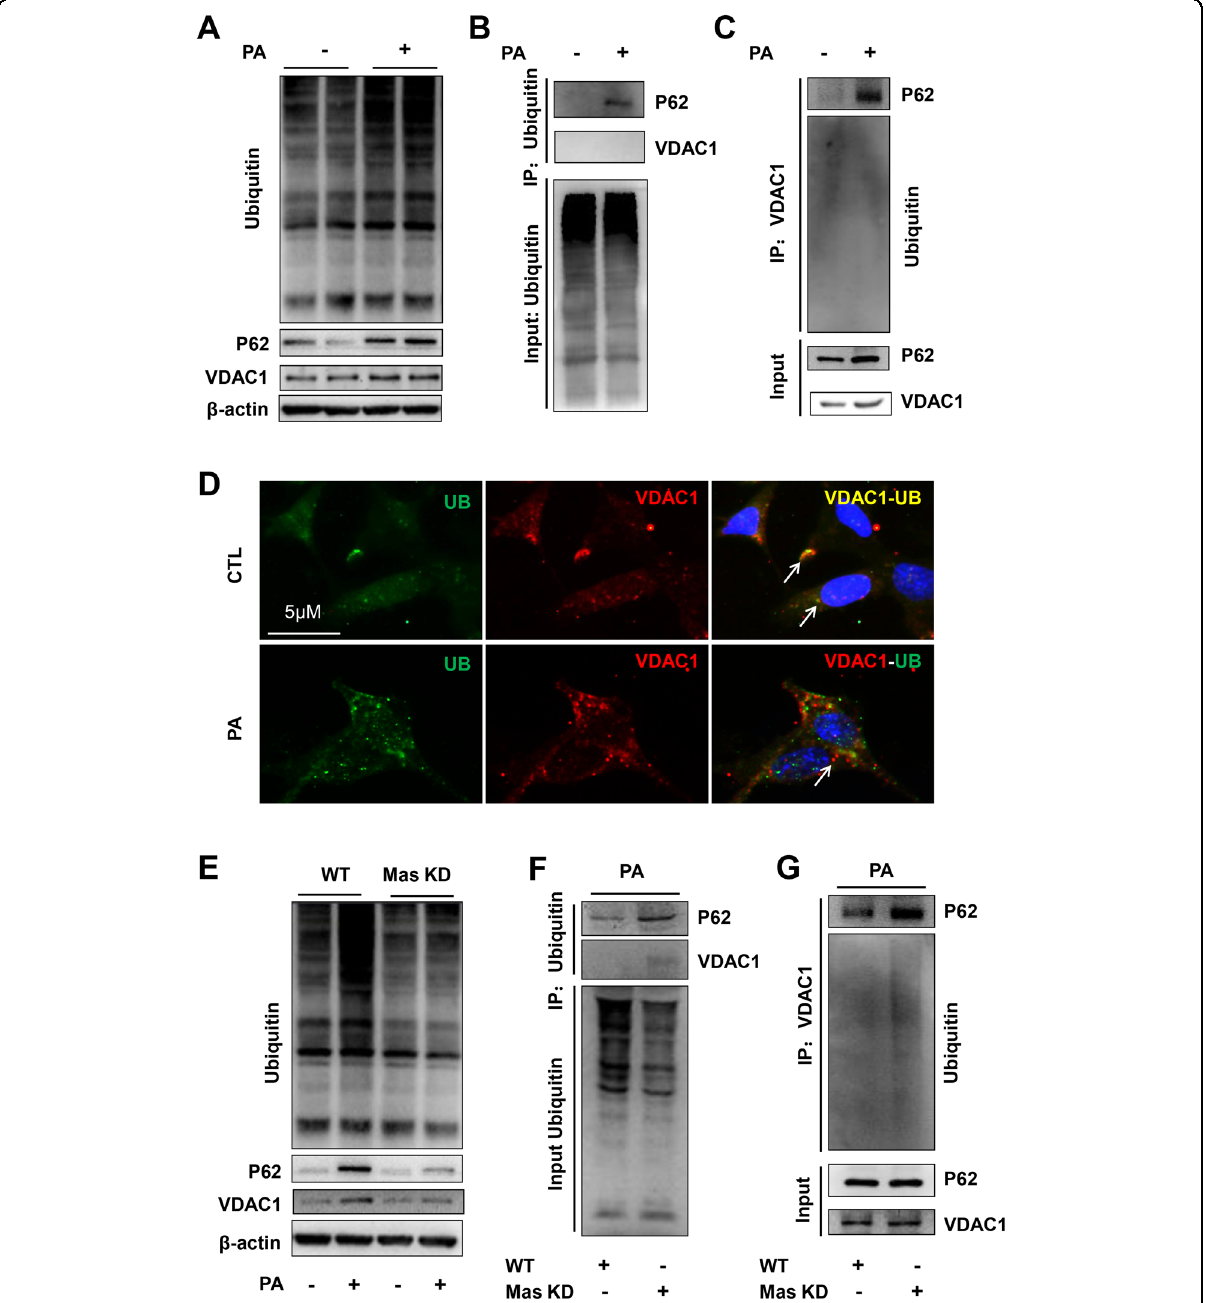
Fig. 7 Mas knockdown (KD) improved incomplete ubiquitination of VDAC1-P62-ubiquitin complex in HK2 cells treated with PA. A Protein expression of VDAC1, P62 and ubiquitin in HK2 cells treated with PA for 24 h. B and C Immunoprecipitation assay showing the interaction among VDAC1, P62, and ubiquitin in HK2 cells with or without PA treatment. D Confocal microscopy images of VDAC1 (red) and ubiquitin (UB) (green) in HK2 cells treated with or without PA, showing more colocalization of VDAC1 and ubiquitin in controls than that in PA-treated cells. E Protein expression of VDAC1, P62 and ubiquitin in WT and Mas KD HK2 cells with or without PA for 24 h. F and G Immunoprecipitation assay showing the interaction among VDAC1, P62 and ubiquitin in WT and Mas KD HK2 cells with or without PA treatment. WT, wild type; Mas KD, Mas knockdown. The experiment was repeated three